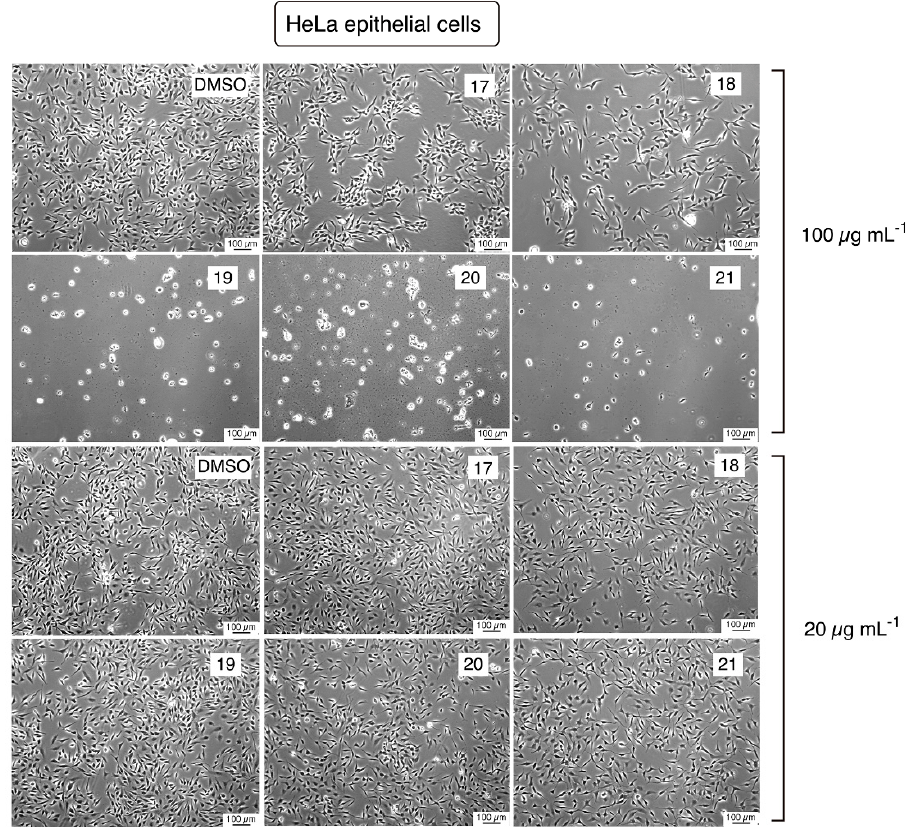
Figure 4. Toxicity assay of the series of compounds 17 to 21 in human HeLa epithelial cells. The cell culture was exposed to the different compounds for 18 h at different concentrations (only 100 µg mL − 1 or 20 µg mL − 1 was indicated). Cells were fixed and imaged in an inverted microscopy as described in Section 4.